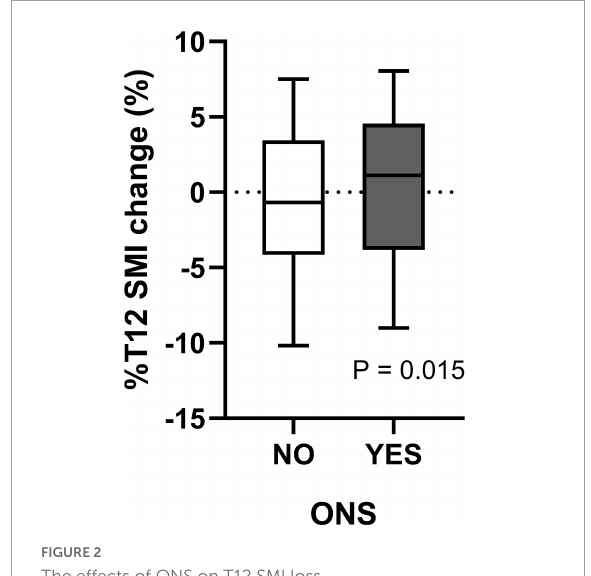
FIGURE2 The effects of ONS on T12 SMI loss.